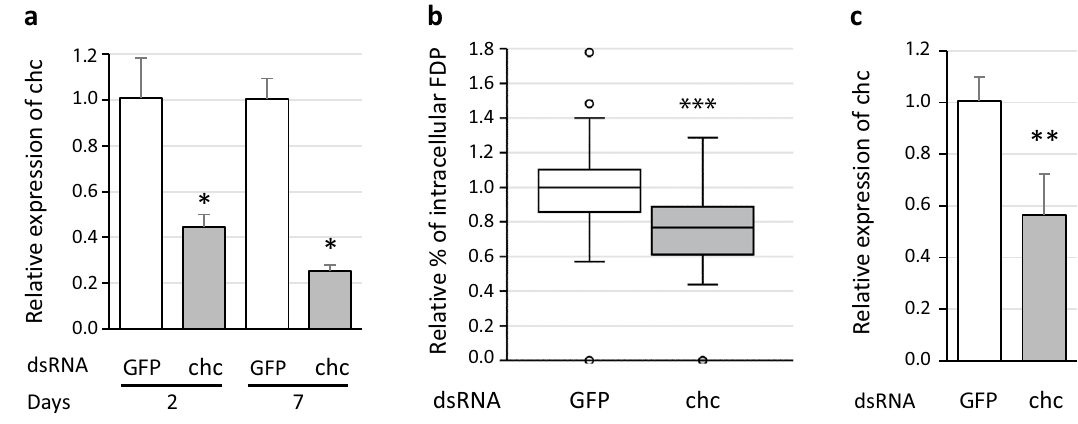
Figure 4. Internalization of FD phytoplasmas (FDP) into S2 cells in presence of dsRNA chc (clathrin heavy chain) and GFP. ( a ) S2 cells were incubated for 2 or 7 days with dsRNA GFP (control, white boxes) or dsRNA chc (grey boxes). Expression of the chc gene was measured regards to the reference genes glutathione S-transferase and elongator factor 1. *Indicates a significant difference with p = 0.0463 at 2 days and p = 0.0495 at 7 days under the Kruskal–Wallis rank sum test of the R commander package of R software version 4.0.3 (R: A language and Environment for statistical computing, R Core Team, R Foundation for Statistical Computing, Vienna, Austria, 2020, https:// www.R- proje ct. org). ( b ) internalization of FD phytoplasmas into S2 cells seven days after the cells were transfected with dsRNA GFP (white) or dsRNA chc (grey). ***Indicates a significant difference with p = 1.3 × 10–10 under the Kruskal–Wallis rank sum test. ( c ) control of RNAi efficiency into S2 cells transfected at the same time as cells infected in ( b ). The chc gene expression was measured regards to the reference genes glutathione S-transferase and elongator factor 1. **Indicates a significant difference with p = 0.00265 under the Kruskal–Wallis rank sum